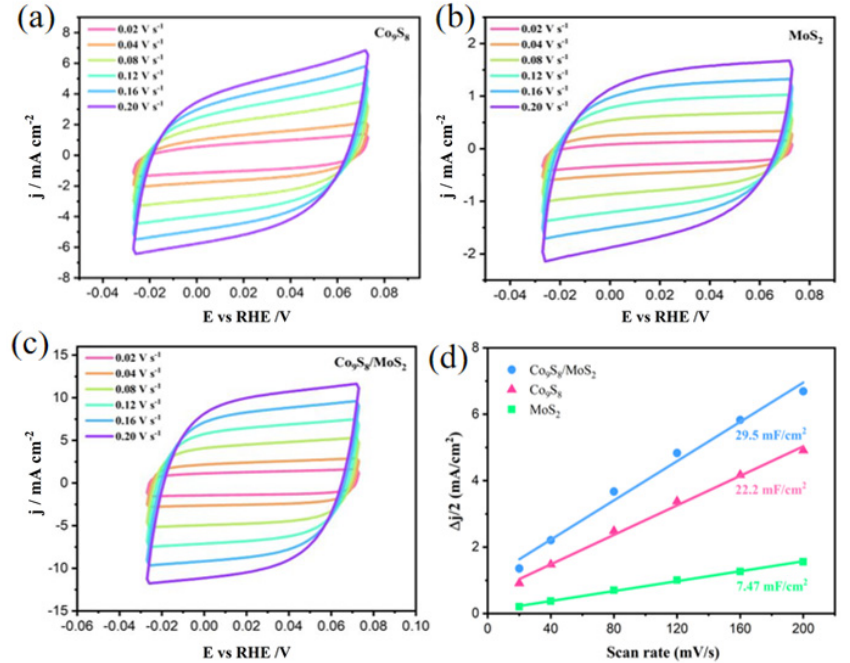
Figure 8. CV curves obtained with different scan rates from 0.02 to 0.20 V s − 1 in 1 M KOH for ( a ) Co 9 S 8 /MoS 2 , ( b ) Co 9 S 8 , and ( c ) MoS 2 ; ( d ) electrochemical double-layer capacitances for Co 9 S 8 , MoS 2 , and Co 9 S 8 /MoS 2 .